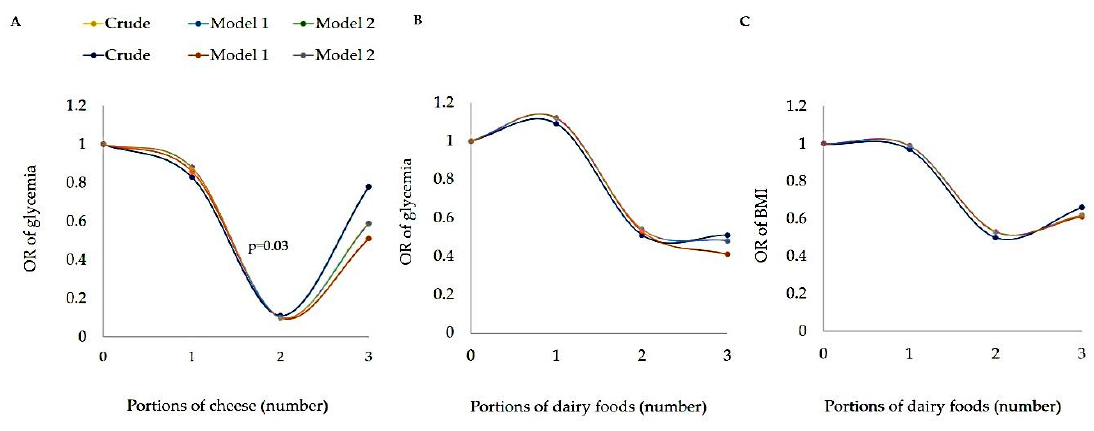
Figure 1. Association between glucose and portions of cheese (A) , glucose and portions of dairy food ( B) and BMI and dairy food (C) — BMI: body mass index. Logistic regression analysis with OR (Odds Ratio) and 95% CI (95% confidence interval). Model 1: adjusted for age and sex; Model 2: adjusted by age, sex, calories and fiber. p < 0.05 was considered as significant.